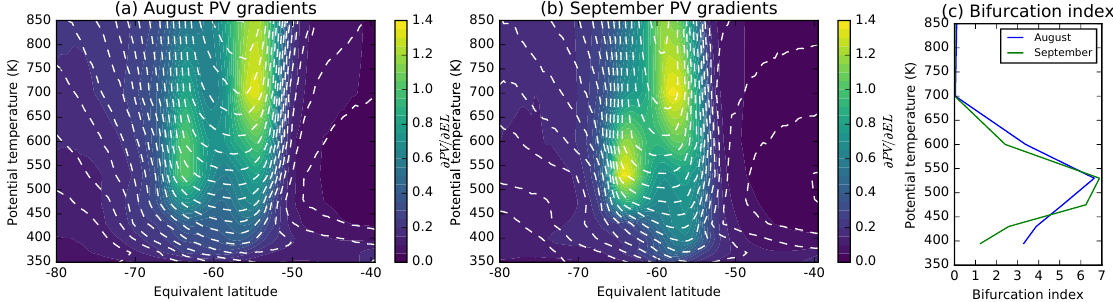
Figure 3. Monthly mean PV gradient (colours; sPVU ◦− 1 ) and wind speed (dashed lines; in 10ms − 1 steps) in 0.5 ◦ bins during (a) August and (b) September 2007 at ERA-Interim levels between 350 and 850K. Also shown is (c) mean BI at each level for each month.